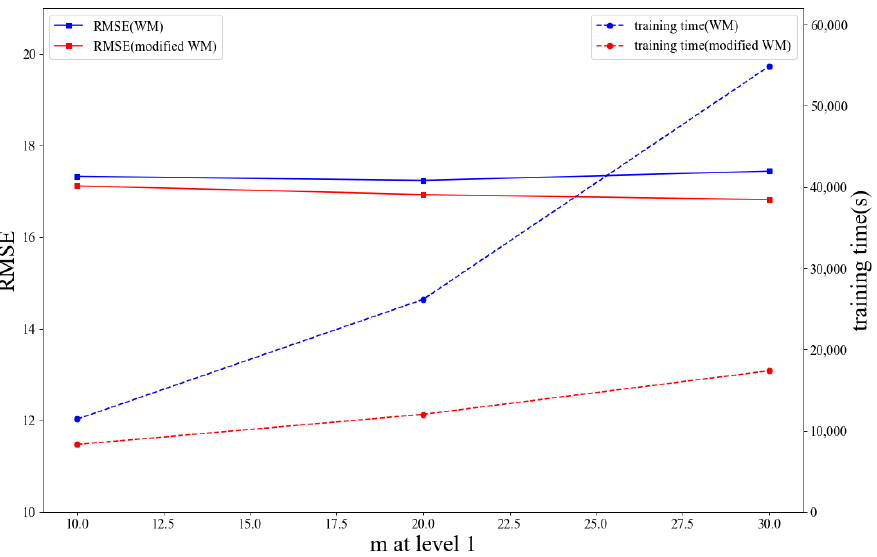
Figure 12. RMSE and training time of the model given different m.